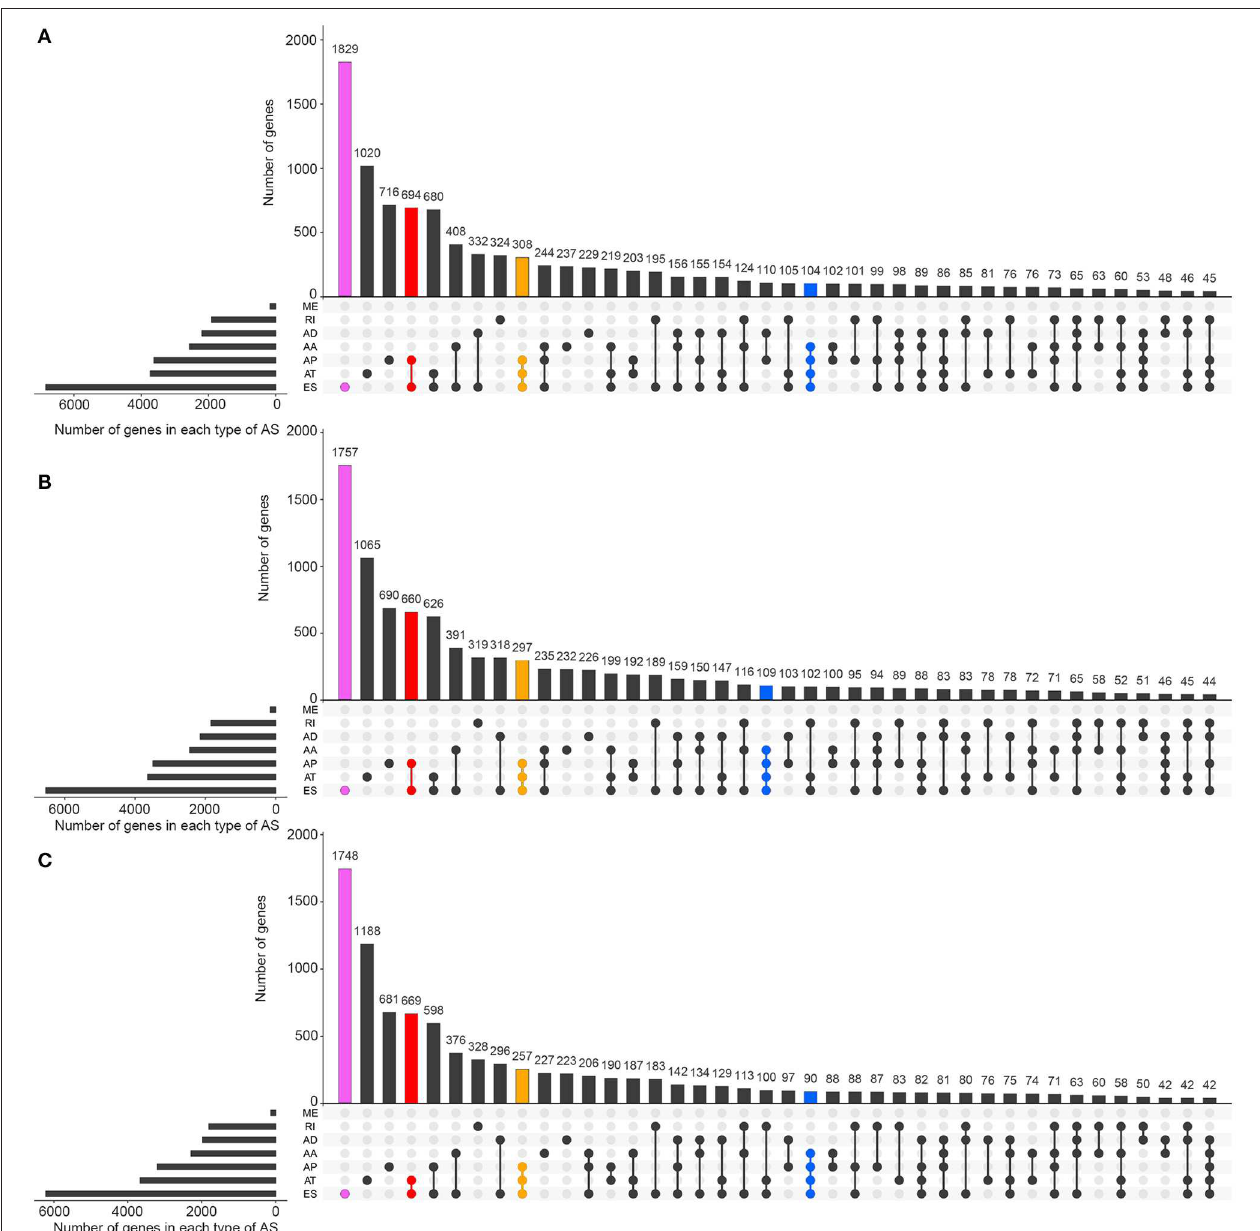
FIGURE 2 | The distributions of ASEs and ASRGs in each kind of RCC. The Upset plot shows the distribution of ASRGs and ASEs in the pan-RCC. The bar chart above represents the number of genes contained in each type of group. The bar chart at the bottom left represents the number of events included in each type of AS events. The dotted line at the bottom right shows the types of events contained in the group. Pink indicates the group with the largest number of ASRGs in the groups containing one event type. Red indicates the group with the largest number of ASRGs in the groups containing two event types. Yellow indicates the group with the largest number of ASRGs in the groups containing three event types. Blue indicates the group with the largest number of ASRGs in the groups containing four event types. (A) KIRC; (B) KICH; and (C) KIRP.